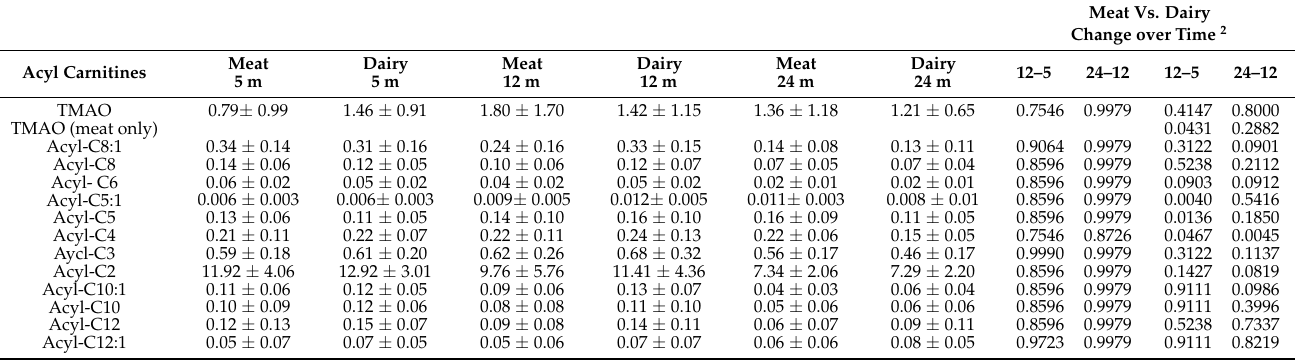
Table 3. Concentrations of acylcarnitines ( µ M) and TMAO at 5, 12 and 24 months between the meat and dairy groups 1 .